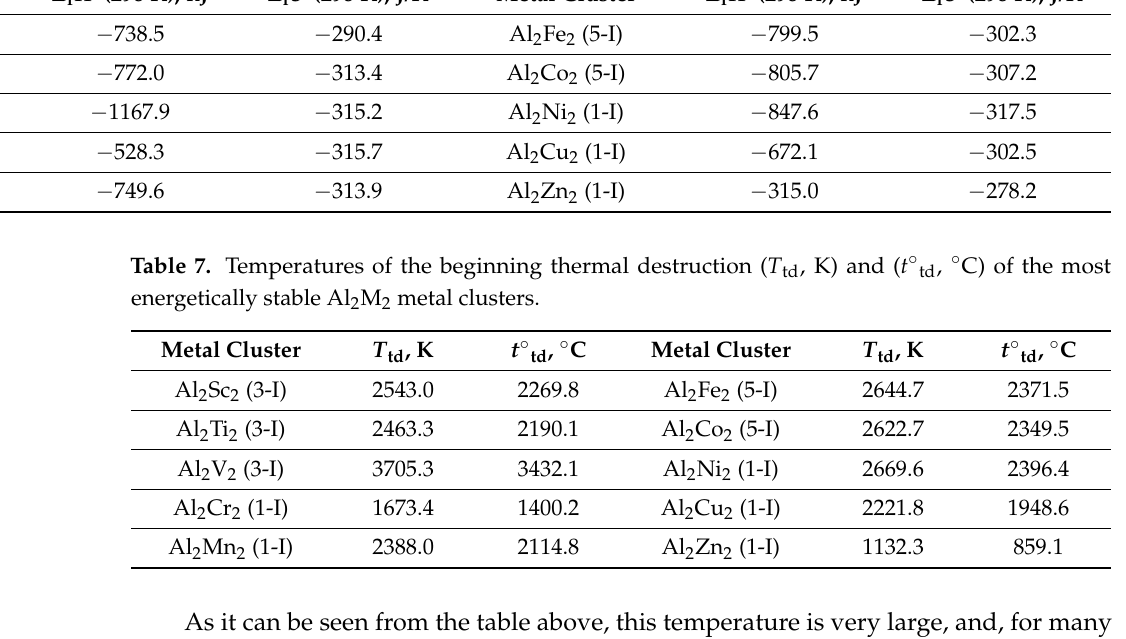
Table 6. Thermodynamic parameters ∆ r H 0 (298 K) and ∆ r S 0 (298 K) for the reactions (1–10) according to DFT OPBE/QZVP method. Metal Cluster